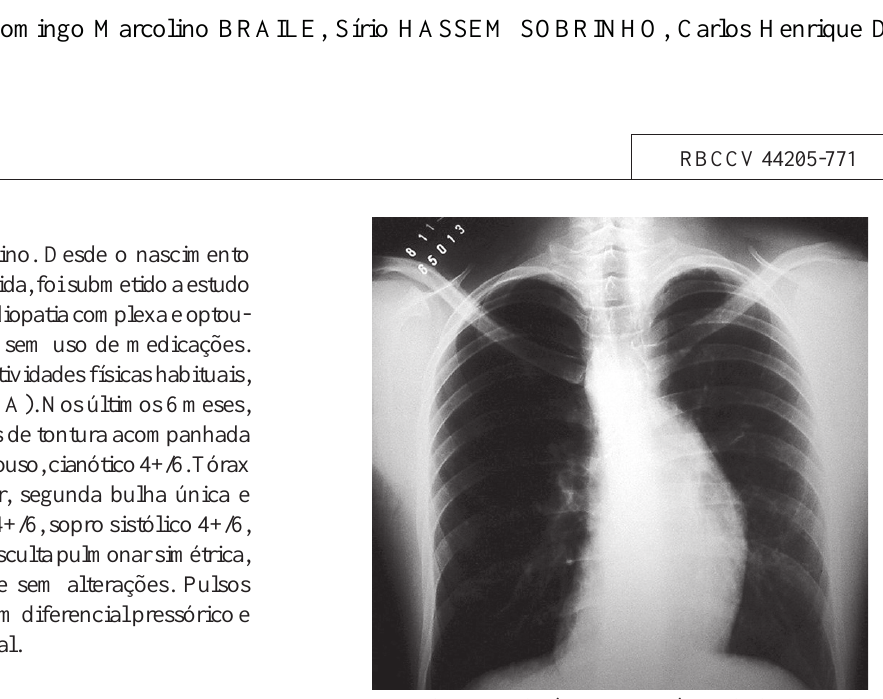
Fig. 1 - Radiograma de tórax característico de dextrocardia com justaposição atrial à